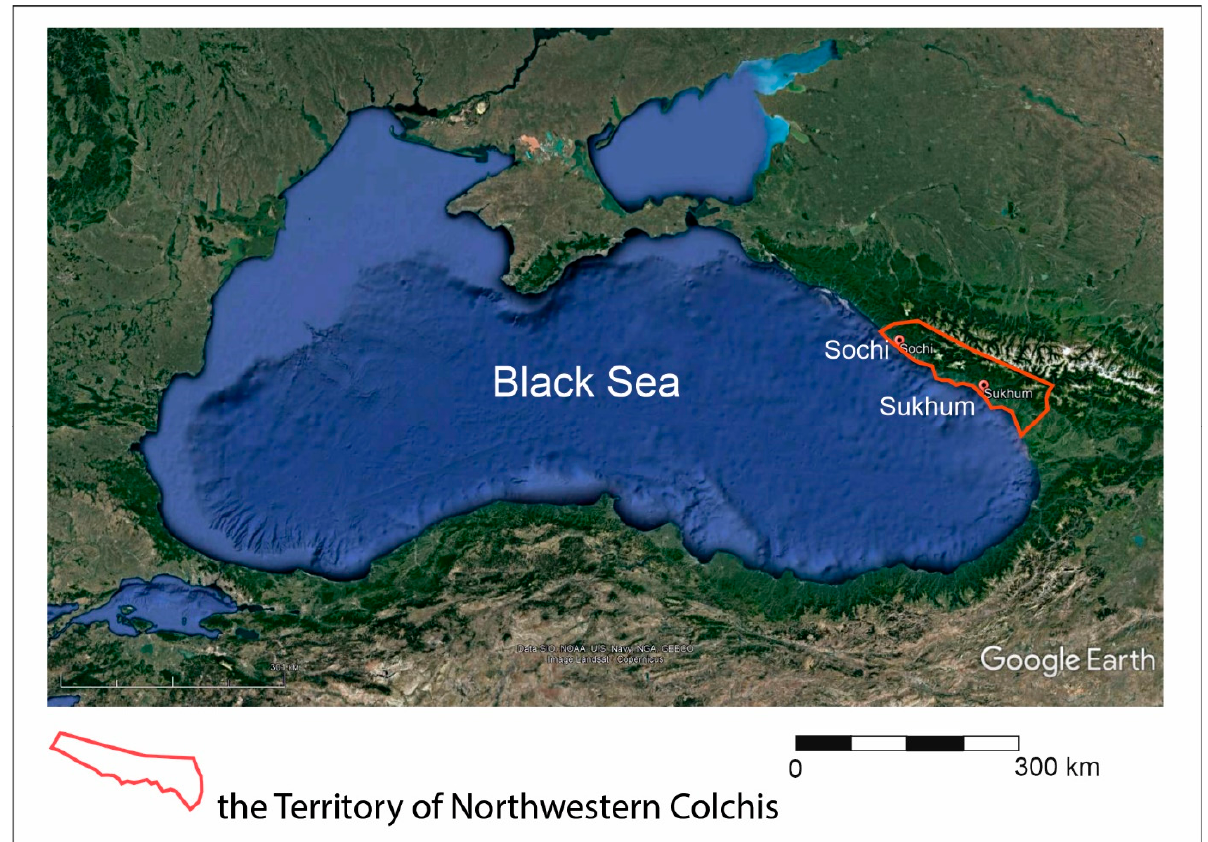
Figure 1. The territory of northwestern Colchis on a satellite image.